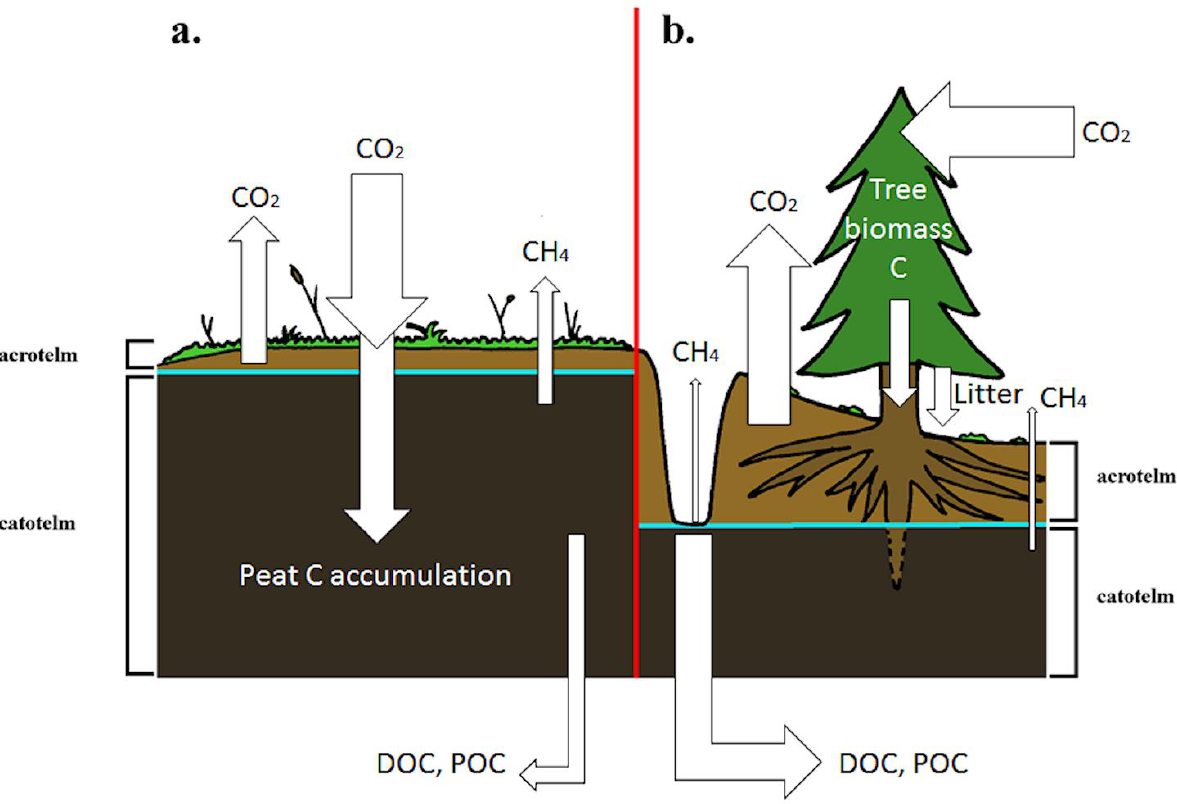
Figure 3. A lowered water table (blue line) gives rise to different rates of carbon loss and accumulation in peatland systems (a) before drainage and (b) after drainage and afforestation, which also cause subsidence. Carbon dioxide (CO ) production will increase with aeration of the upper layer of peat, with a reduction of 2 methane (CH ) production from waterlogged peat. Loss of aquatic dissolved and particulate carbon (DOC 4 and POC) may be increased through drainage. Carbon is taken up by vegetation in both scenarios. In an undrained bog some of this will go on to be stored in peat over long timescales, whereas in the drained system it will form tree biomass, eventually reaching the soil as litter and roots or being removed from the site as harvested timber. Unlike Sitka spruce, lodgepole pine is tolerant of waterlogging, and its roots can extend below the water table. The peat beneath the tree crop will have increased dry bulk density compared with the non-afforested peat bog. Flux magnitudes indicated by arrow widths are indicative and open to varying and different degrees of uncertainty and to variation with site